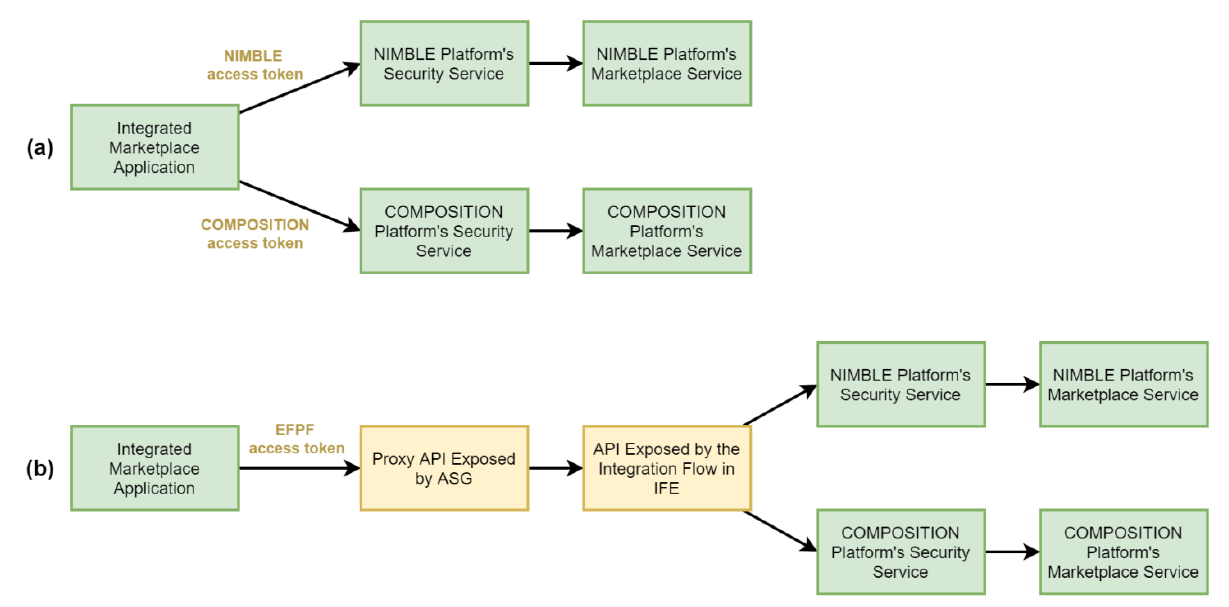
Figure 15. High-level workflows and API calls for realising the integrated marketplace solution: ( a ) the traditional approach, and ( b ) the Data Spine approach.